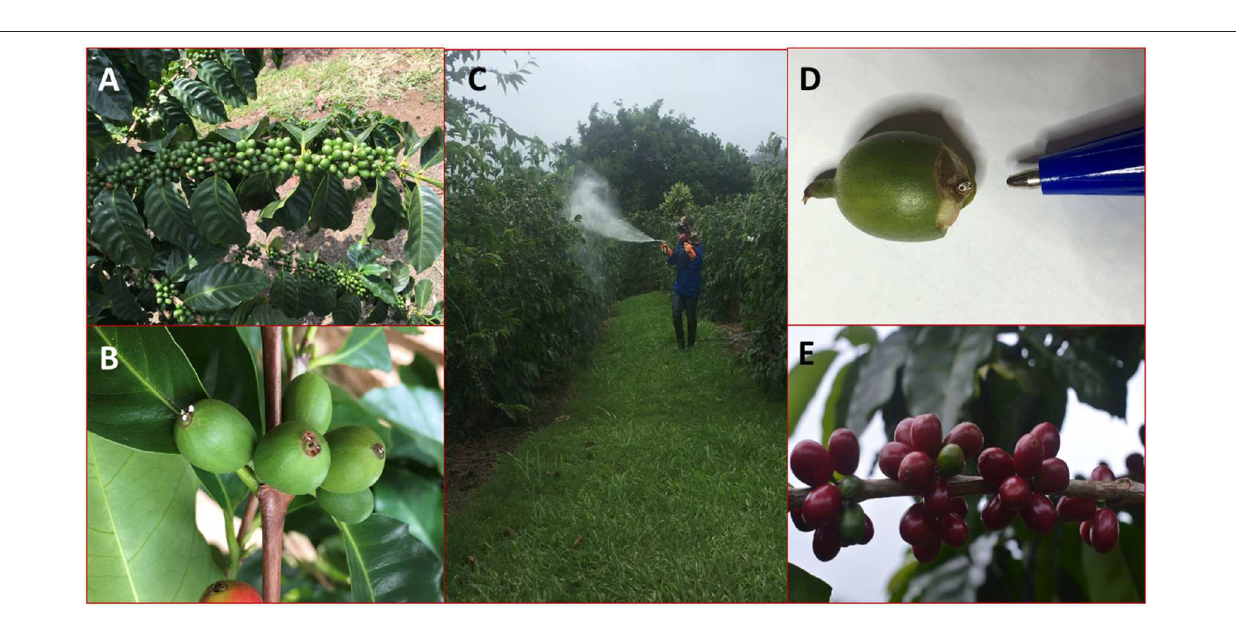
FIGURE 2 | Seasonal coffee phenology. (A) Green developing berries where CBB infestation starts. (B) CBB female infected by B. bassiana with conspicuous white mycelium at the tip outgrowing the CBB cadaver. (C) Early-season B. bassiana application with pressurized sprayer. (D) Evaluation of CBB infected with B. bassiana . (E) Red coffee “cherries” at